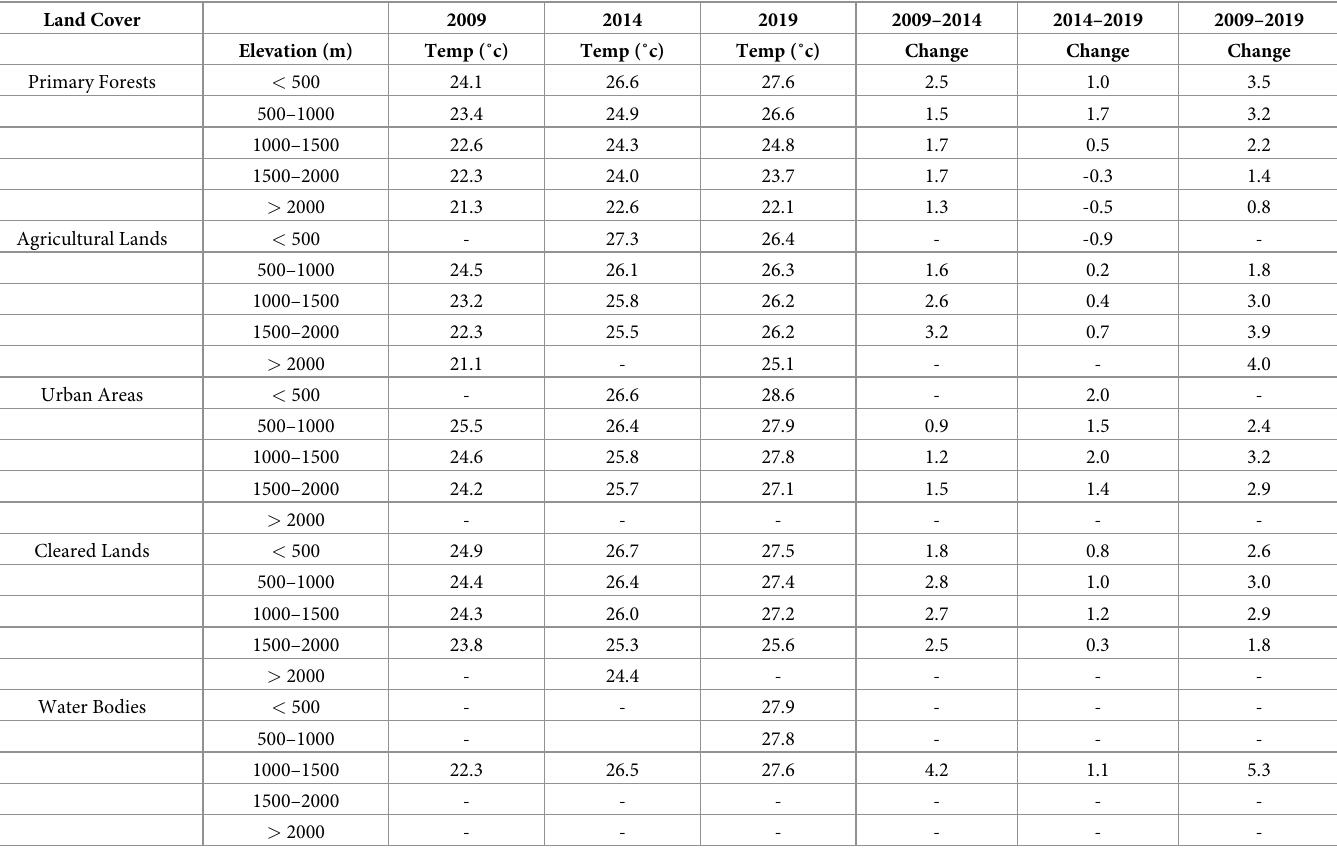
Table 8. LST trend per land cover–elevation